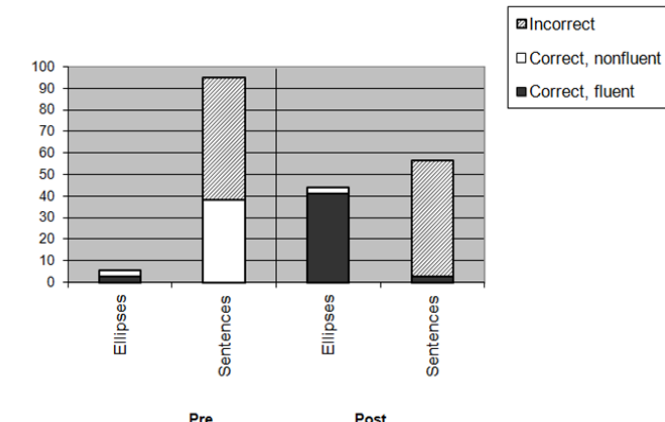
Figure 3. Type of ellipses and sentences produced on the pre-therapy (T1) and post-therapy (T2) Picture Description Task (PDT: for an explanation see